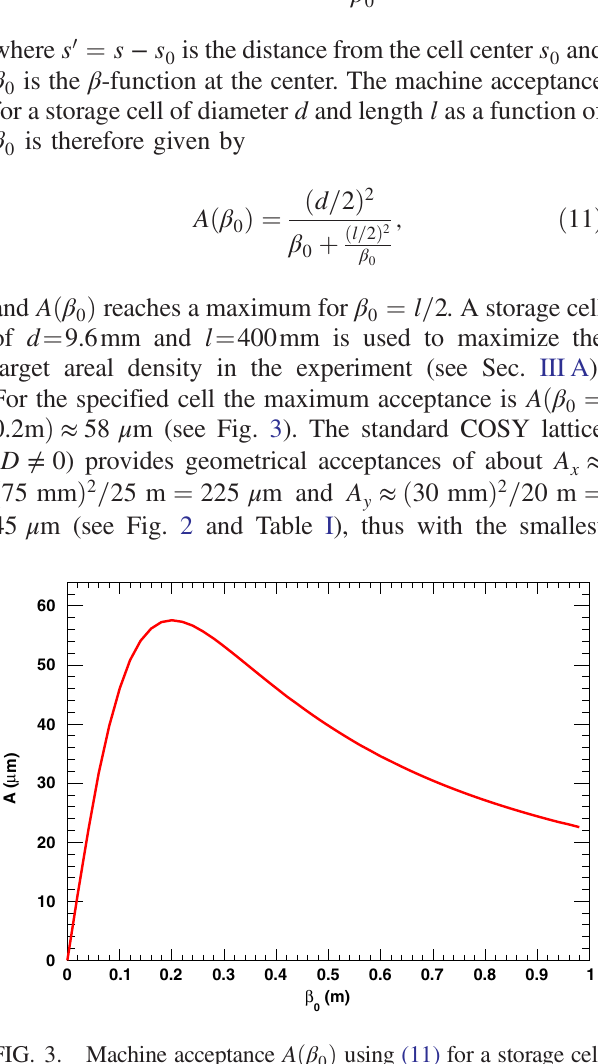
β ¼ l= 2 ¼ 0 . 2 0